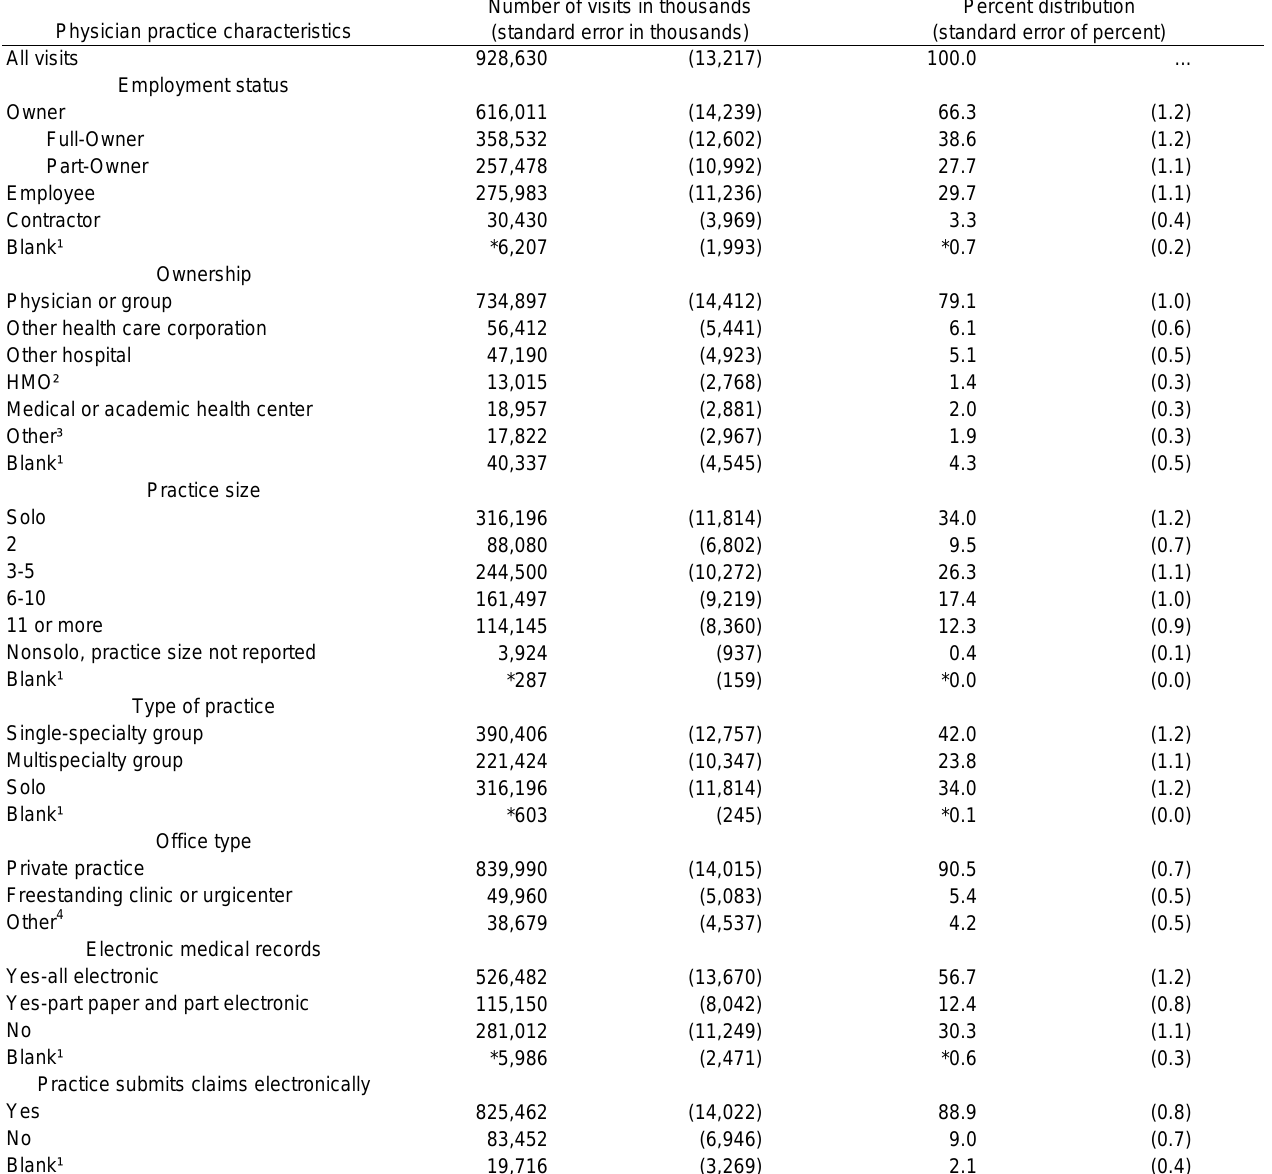
Table 3. Office visits, by selected physician practice characteristics: United States,